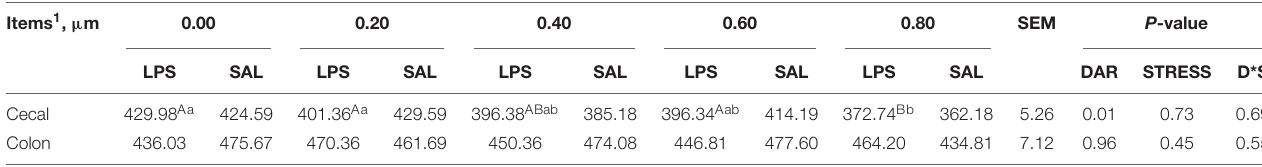
TABLE 6 | Effect of DAR on crypt depth of the intestine of weaned piglets challenged with E. coli LPS. Items 1 , µ